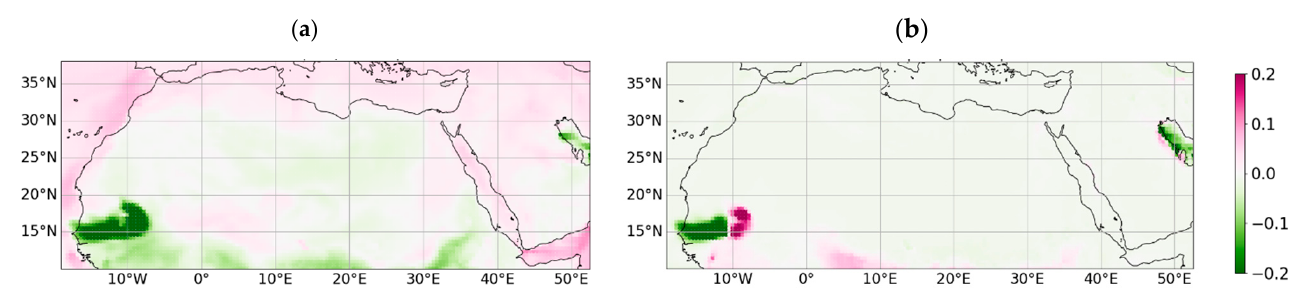
Figure 6. Shapley values for ( a ) raw CHIMERE AOD, ( b ) specific humidity, ( c ) PM 10 , and ( d ) nitrate particles for the RF model for the 30 September 2021.